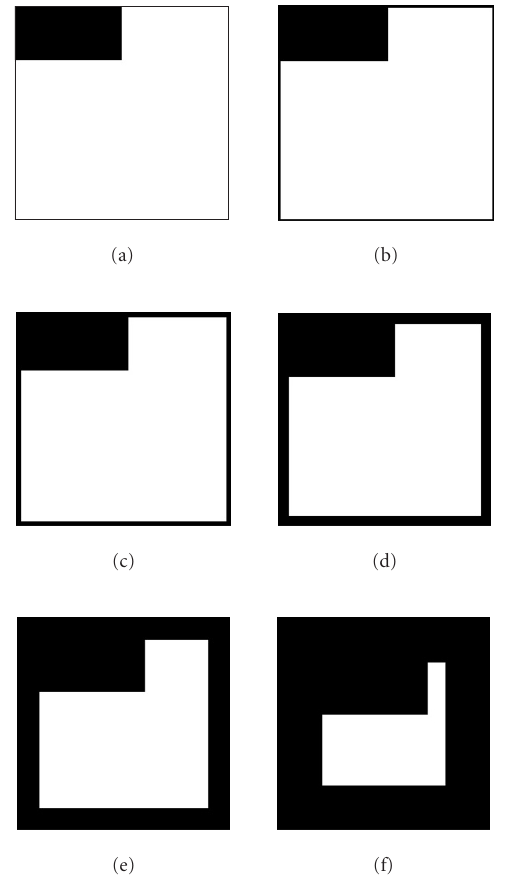
Figure 5: (a) Mask used to simulate a gap in the data. (b)–(f) Mod- ified masks at scales 1 through 5. The discarded pixels are in